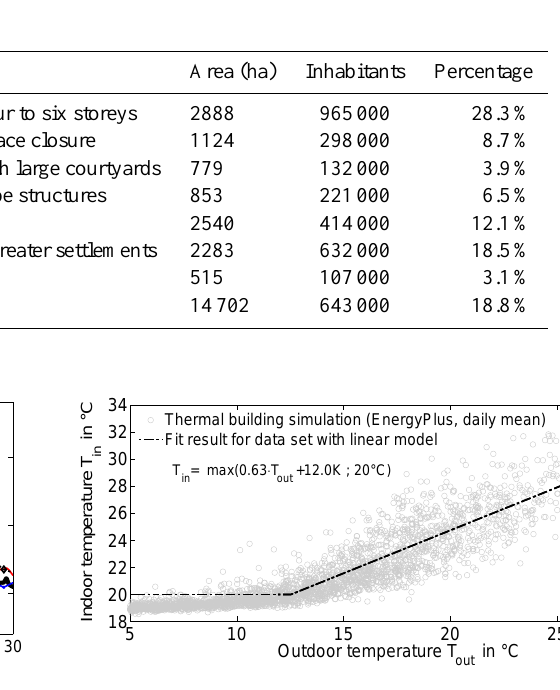
Figure 2. Outdoor air temperature and indoor temperatures for July 2007 calculated from building models parametrized according to Sec. 3.1.